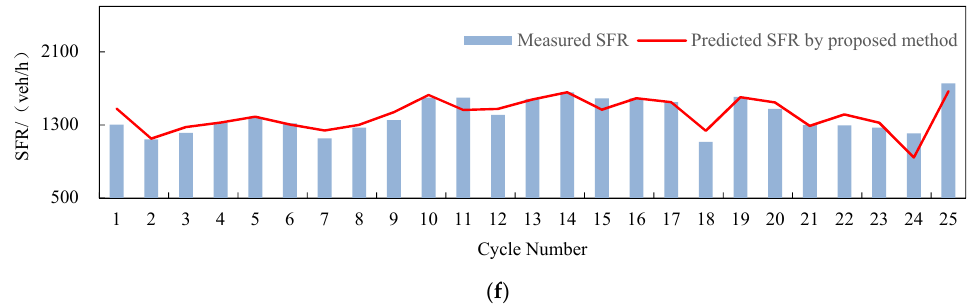
Figure 7. Comparison between predicted and measured saturation flow rate (SFR) with training and test sets: ( a ) comparison between predicted and measured results with the training set in scenario 1; ( b ) comparison between predicted and measured results with the test set in scenario 1; ( c ) comparison between predicted and measured results with the training set in scenario 2; ( d ) comparison between predicted and measured results with the test set in scenario 2; ( e ) Comparison between predicted and measured results with training set in scenario 3; ( f ) comparison between predicted and measured results with the test set in scenario 3.